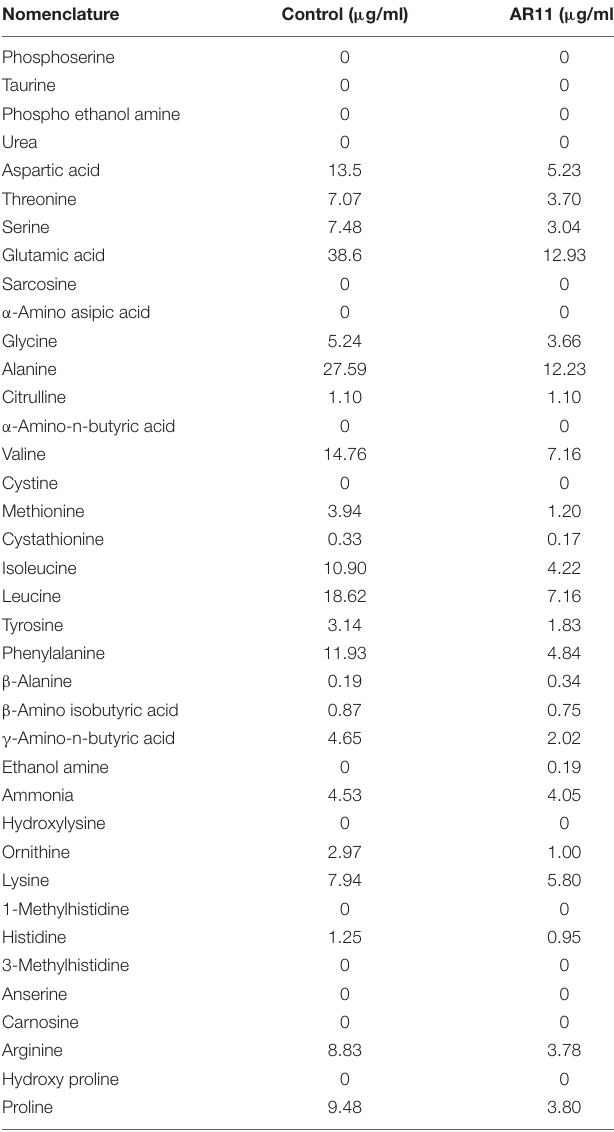
TABLE 3 | Free amino acid intake potential of Curvularia lunata